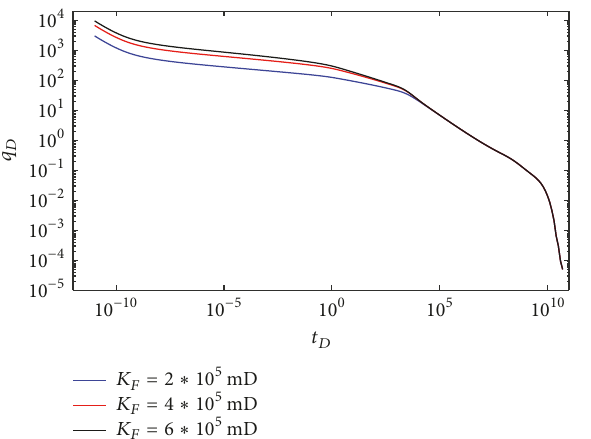
Figure 7: Effect of Langmuir volume ( 𝑉 𝐿 ) on pressure.